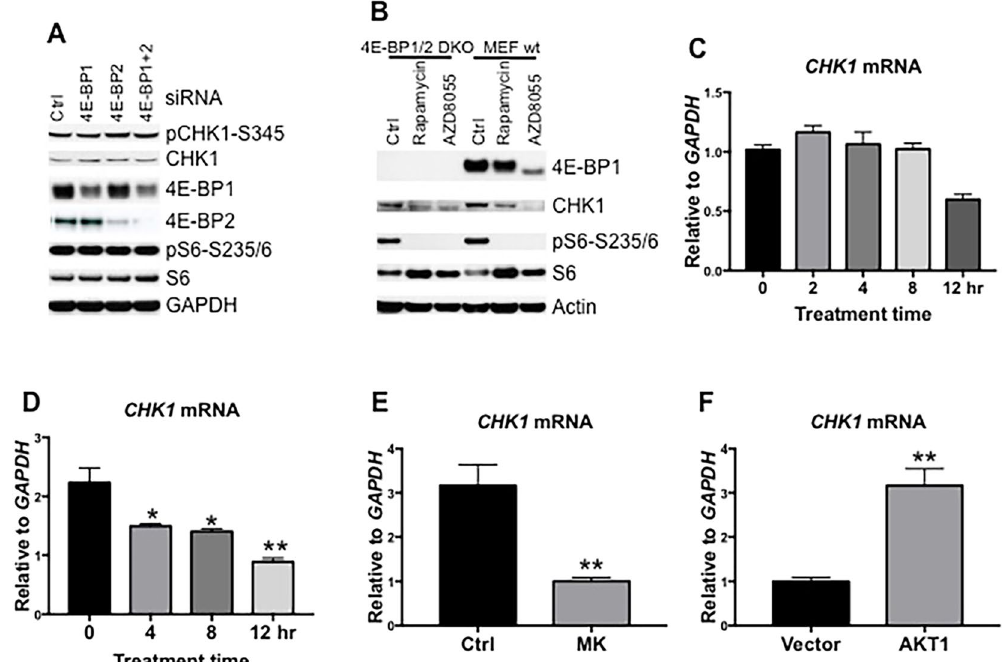
Figure 3. The mTOR Pathway Regulates CHK1 at Transcription Level. ( A ) Rh30 cells were transfected with control, 4E-BP1, 4E-BP2 and 4E-BP1 plus 4E-BP2 siRNAs. 48 hr later, total proteins were extracted for immunoblotting. ( B ) Wild type (MEF wt) and 4E-BP1/2 DKO MEF cells were treated with rapamycin (100 ng/ mL) or AZD8055 (1 μ M) for 24 hr. Total proteins were extracted for immunoblotting. ( C ) Rh30 cells were treated with rapamycin (100 ng/ml) for the time indicated. The total RNA was extracted to detect CHK1 mRNA by real-time RT-PCR with GAPDH as internal control. Relative quantity of CHK1 mRNA was plotted. ( D ) Rh30 cells were treated with AZD8055 (1 μ M) for the time indicated. The total RNA was extracted to detect CHK1 mRNA by real-time RT-PCR with GAPDH as internal control. Relative quantity of CHK1 mRNA was plotted. ( E ) Rh30 cells were treated with MK2206 (MK) for 12 hr. Total RNA was extracted to detect CHK1 mRNA by real-time RT-PCR with GAPDH as internal control. Relative quantity of CHK1 mRNA was plotted. ( F ) Rh30 cells were transfected with vector or AKT1-wt (AKT1) plasmid. 48 hr later, the total RNA was extracted to detect CHK1 mRNA by real-time RT-PCR with GAPDH as internal control. Relative quantity of CHK1 mRNA was plotted. Error bars: Mean ± SD (n = 3). * P < 0.05; ** P < 0.01. Immunoblots were converted to gray with auto tone by Photoshop